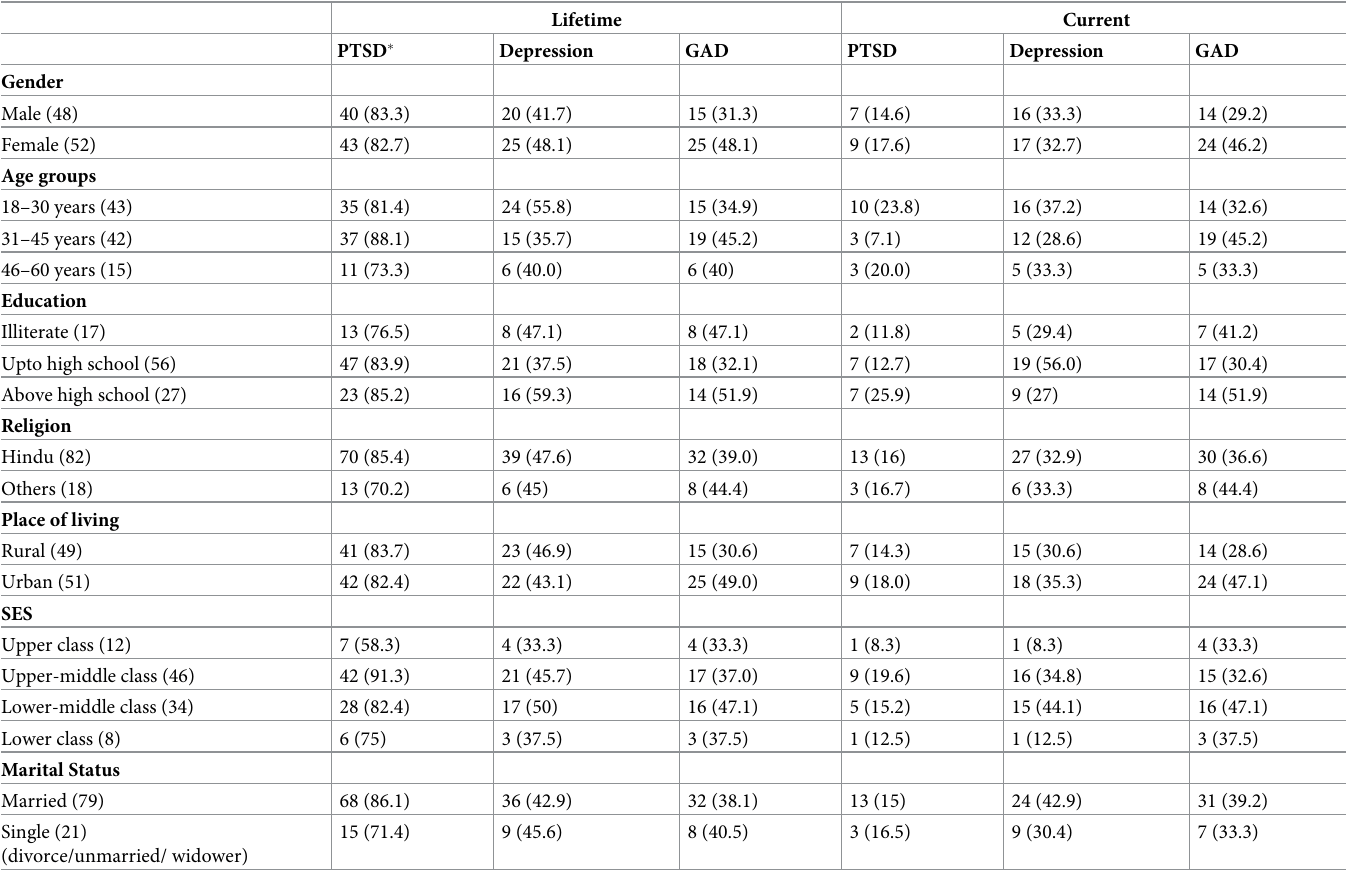
Table 3. Rates of psychiatric disorders according to sociodemographic